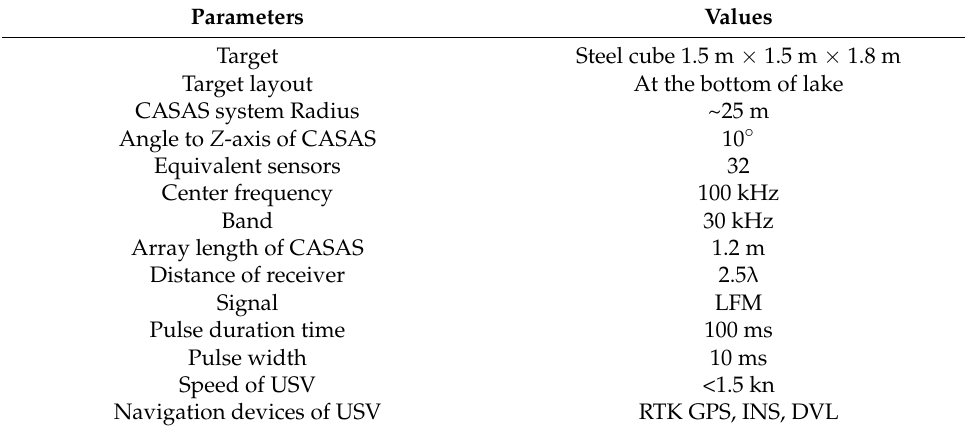
Table 3. CASAS system parameters for experiment.